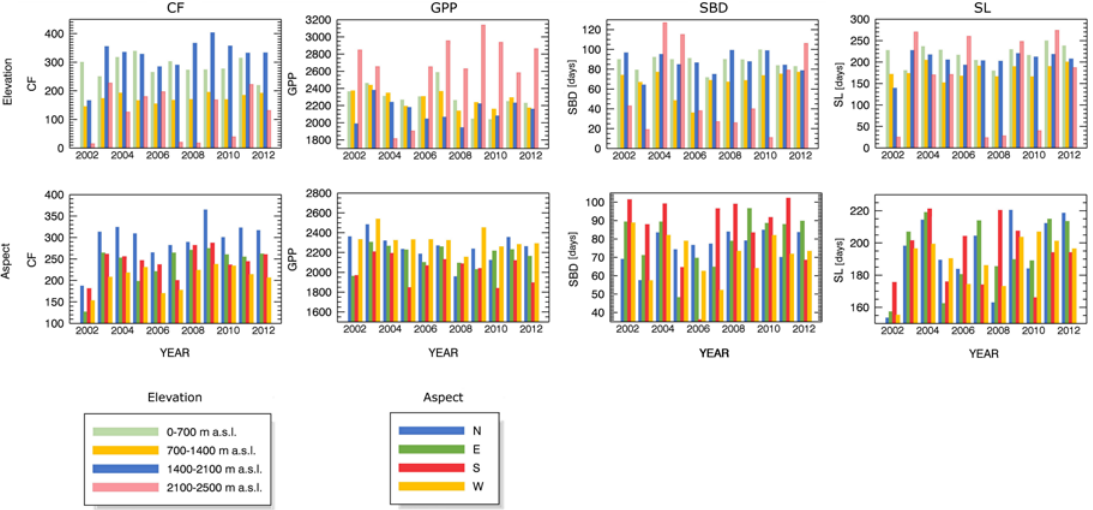
Figure 7. Marginal means plots of repeated measures ANOVA showing CF, GPP, SBD and SL variability (in columns) in relation to elevation and aspect (in rows). Analyses performed for the 3nNDVI drought impact class 3 spatial footprint. Categories plotted in transparent comprise less than 50 observations. Abbreviations are explained in Figure 3.